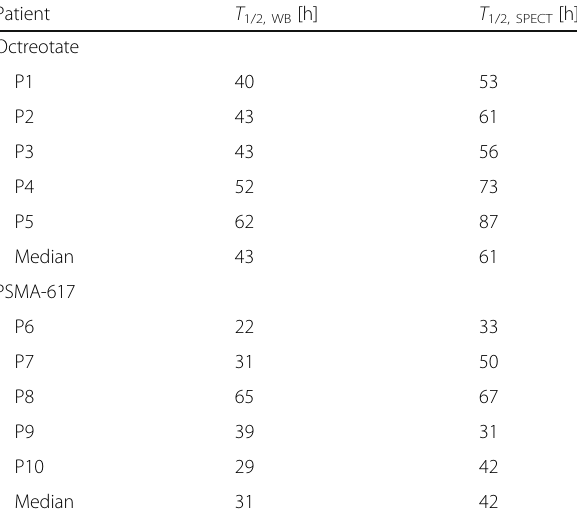
Table 5 Comparison of planar-based whole-body ( T 1/2, WB ) and SPECT-based abdominal effective half-lives ( T 1/2, SPECT ) for Lu- 177-PSMA-617 and Lu-177-Octreotate